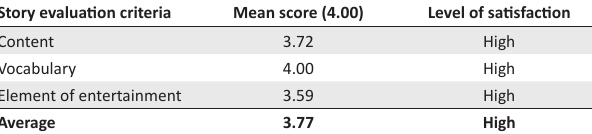
TABLE 5: Parents’ evaluation of the stories. Story evaluation